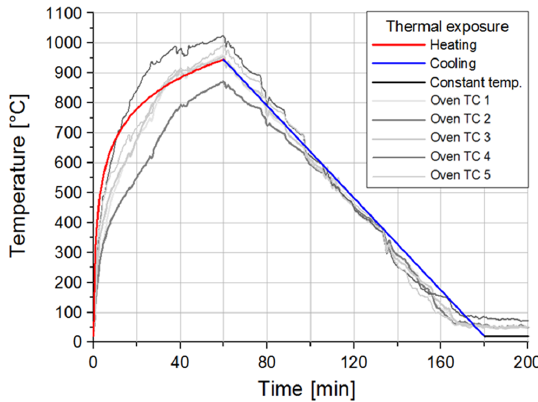
Figure 6. ISO 834 heating curve compared against measured temperature (Parmar et al. [33]).